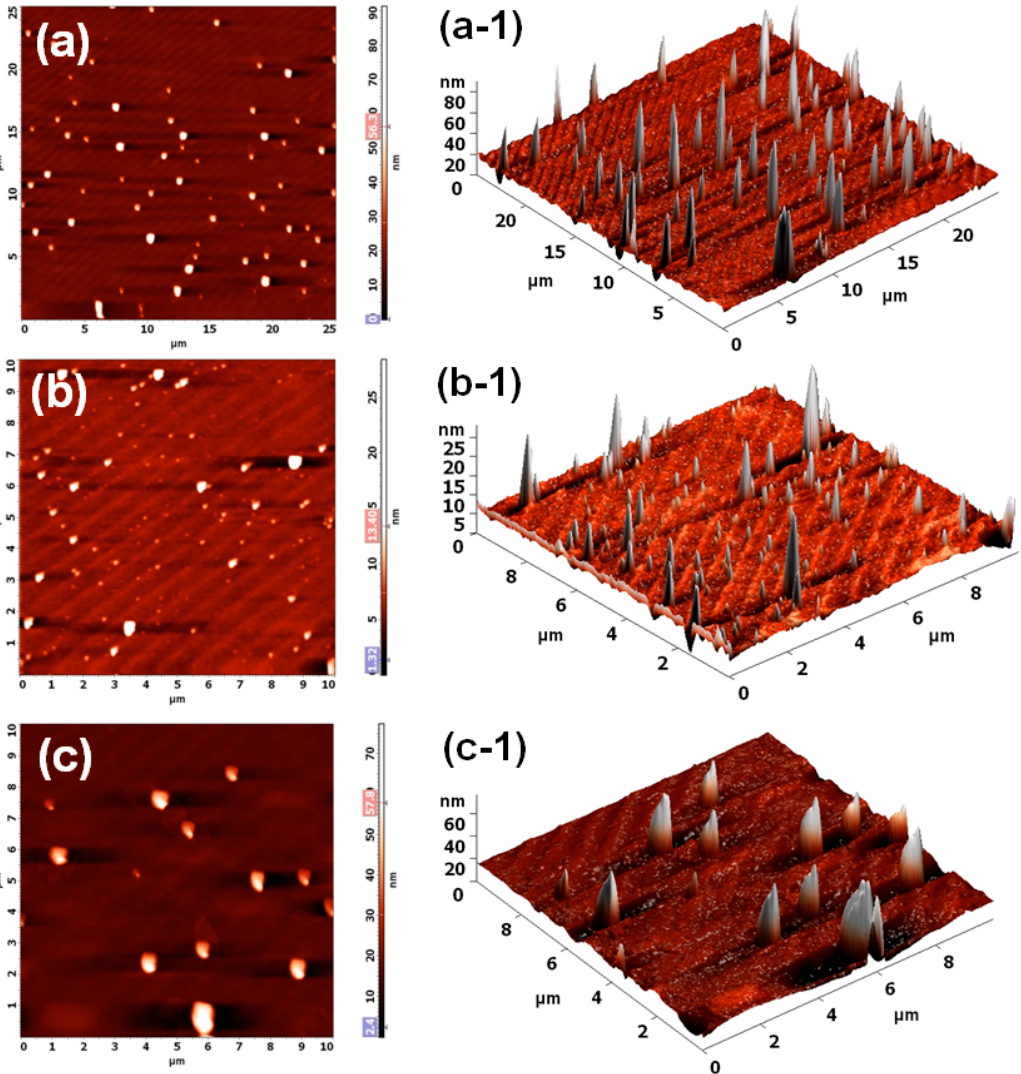
Figure 3. AFM images of ( a , a-1 ) Ni/GO-1, ( b , b-1 ) Ni/GO-2, and ( c , c-1 ) Ni/GO with 15 wt% of Ni (Ni/GO-3); performed directly on the surface of samples and their three-dimensional projections.